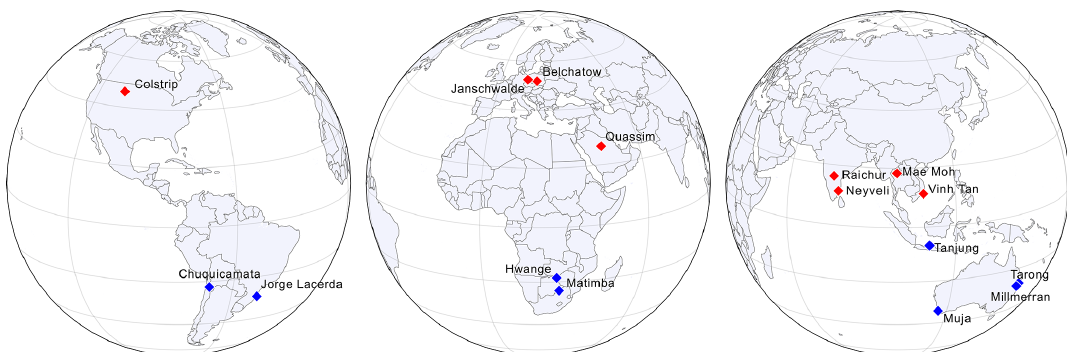
NA stands for not available.